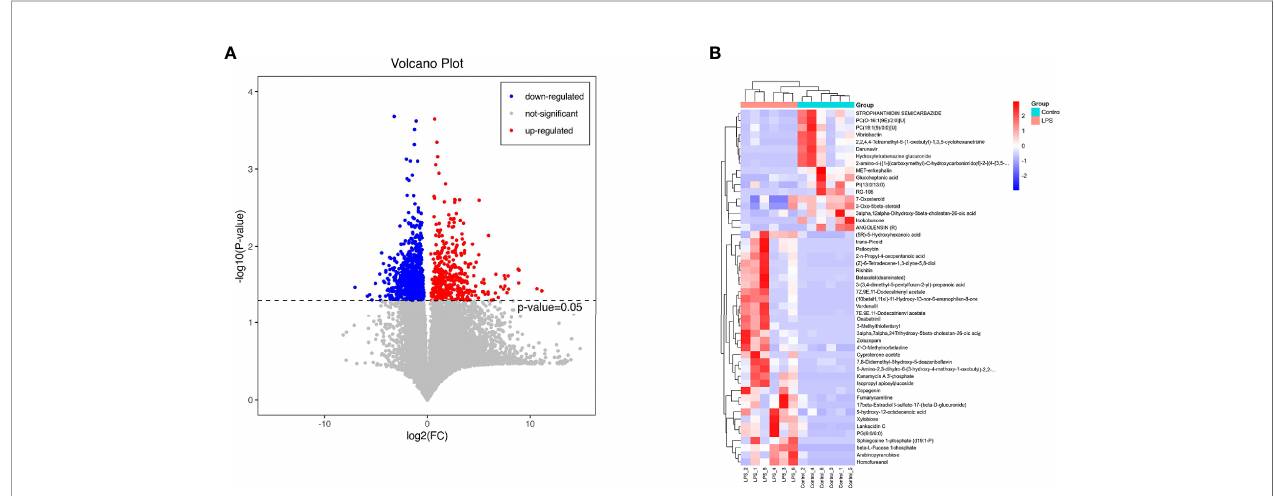
FIGURE 6 | Effects of LPS on the intestinal metabolites in mice. (A) Signi fi cantly different metabolites, in which the red dots represent signi fi cantly upregulated differential metabolites in the LPS group, the blue dots represent signi fi cantly downregulated differential metabolites, and the gray dots represent insigni fi cant differential metabolites. (B) HCA. The abscissa expresses the sample name, and the ordinate represents the differential metabolites. The color ranges from blue to red, indicating the expression abundance of metabolites from minimal to high, that is, the greater the intensity of the red color, the higher is the expression abundance of differential